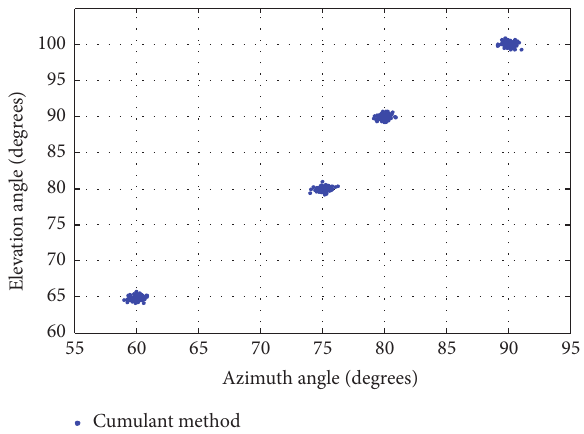
Figure 6: Scatter plot for azimuth and elevation for four uncorre- latedsourcesat (65 ∘ , 60 ∘ ) , (80 ∘ , 75 ∘ ) , (90 ∘ , 80 ∘ ) ,and( 100 ∘ ,90 ∘ ) atSNR = 10dB using cumulant method [17].